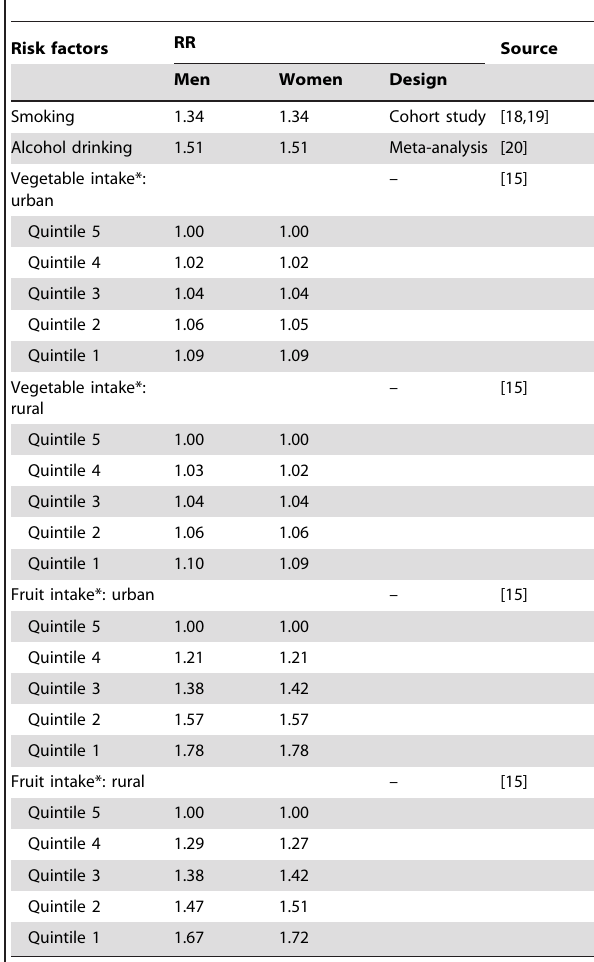
Table 1. Relative risks (RR) between selected risk factors and esophageal cancer, used in the calculation of Population Attributable